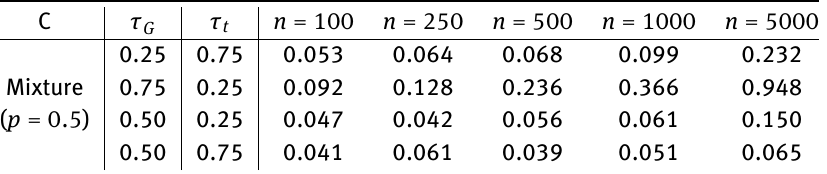
Table 10: d = 2 : Empirical power of the test for ellipticity with significance level α = 0.05 based on the test statistic T n : rate of rejecting H 0 as observed in 1000 random samples of size n from a copula C derived from the mixture of bivariate elliptical distributions with Kendall’s tau combinations ( τ G , τ t ) .